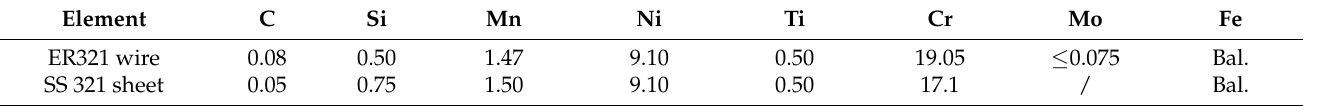
Table 1. Chemical composition of ER321 feeding wire and SS 321 sheet